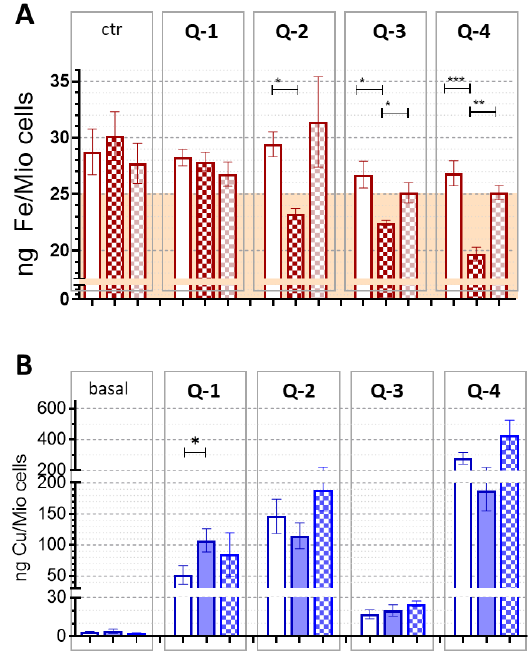
Figure 4. Effect of the compounds on intracellular metal levels. ( A ) Iron levels of MES-SA (open columns) and MES-SA/B1 cells in absence (dark red squared columns) and presence of Pgp inhibitor Tariquidar (bright red squared columns). Cells were loaded with 25 µ M holo-transferrin (4 h), followed by an incubation (8 h) without (ctr) or with 5 µ M of ligands Q-1 , Q-2 , Q-3 , and Q-4 . Basal levels (of control cells prior to holo-transferrin-loading) were at a comparable level, indicated by the colored background. ( B ) Cellular copper levels measured following a 4 h co-administration of compounds Q-1 , Q-2 , Q-3 , and Q-4 (1 µ M) and CuCl 2 (5 µ M) in MES-SA (open columns), MES- SA/Dx5 (filled columns) and MES-SA-B1 (squared columns) cells. Significance is given as *: p ≤ 0.05, **: p ≤ 0.01, ***: p ≤